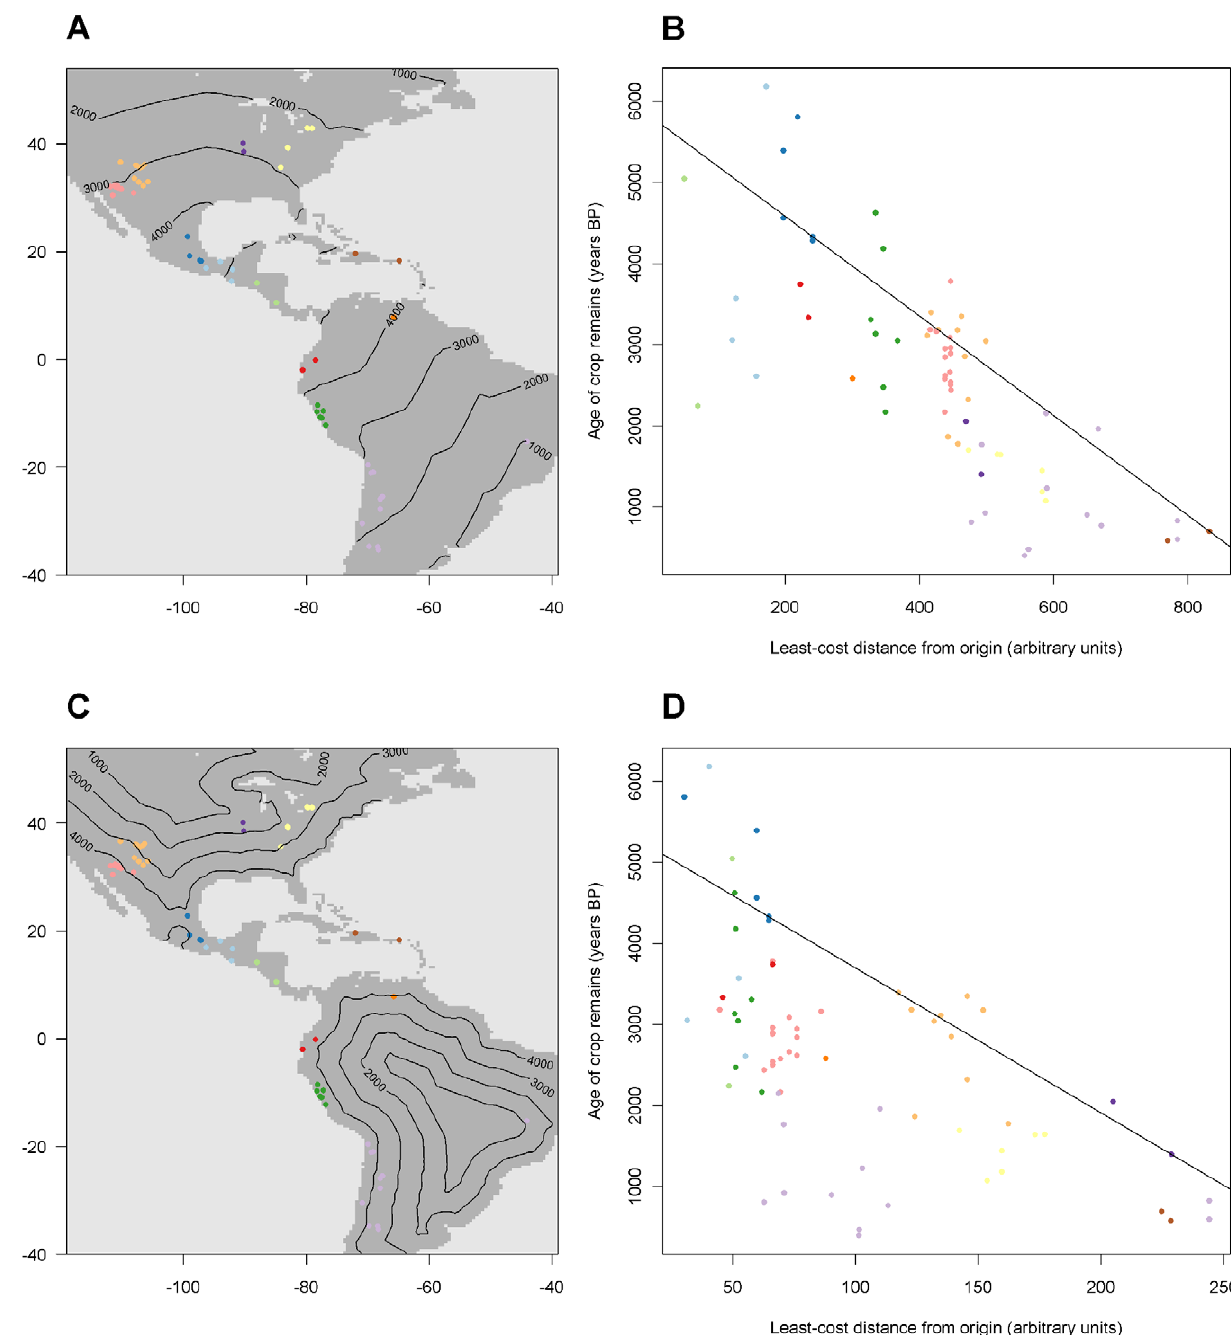
Figure 4. Crop remain age according to two contrasting Pareto solutions. A. Locations of the archaeobotanical observations with modelled isochrons (oldest quintile of macrobotanical remains) for solution A. B. Relation between the age of crop remains and the least-cost distance from the crop origin according to solution A. The colors of the observations correspond to Figure 4A. The line indicates the highest quintile ( t =0.8) predicted by the model. C. Locations of the archaeobotanical observations with modelled isochrons (oldest quintile of macrobotanical remains) for solution A. D. Relation between the age of crop remains and the least-cost distance from the crop origin according to solution A. The colors of the observations correspond to Figure 4C. The line indicates the highest quintile ( t =0.8) predicted by the model. The results also demonstrate a fairly good predictivity of path overlap and non-overlap metrics for genetic distances. The best of the obtained goodness-of-fit values are reasonable when consid- ering the simplicity of our model and values obtained in similar studies [cf. 59].